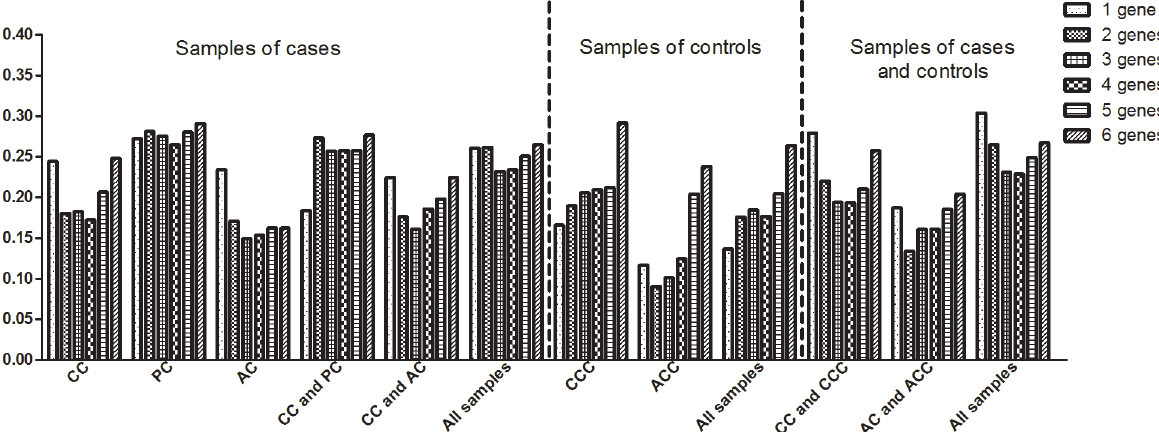
Fig 2. Accumulated standard deviation for the 6 reference genes in tendon samples. Lower values of accumulated standard deviation (Acc.SD) indicate the optimal number of reference gene as estimated by the GenEx software package. CC: central cuff (injured supraspinatus tendon) samples